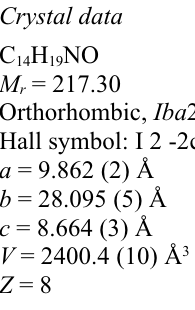
Cell Plot of the title compound ( bc -view, inclusive hydrogen atoms) N -(prop-2-ynyl)tricyclo[3.3.1.1 3,7